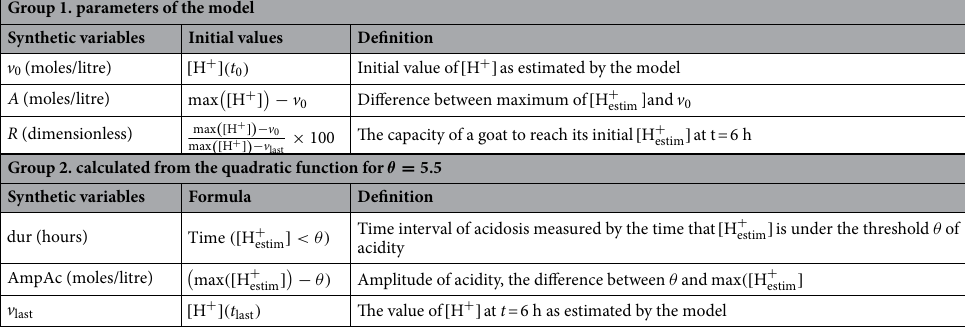
+ estim ] is under the threshold θ of ] < θ , estim